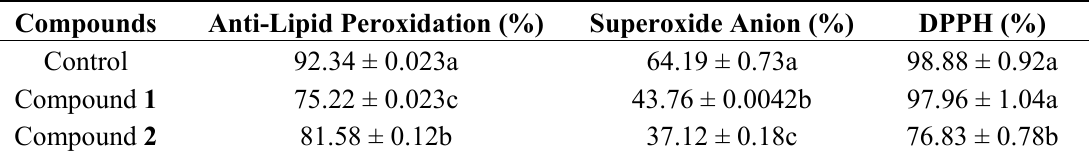
Table 1. Antioxidant activities of isolated